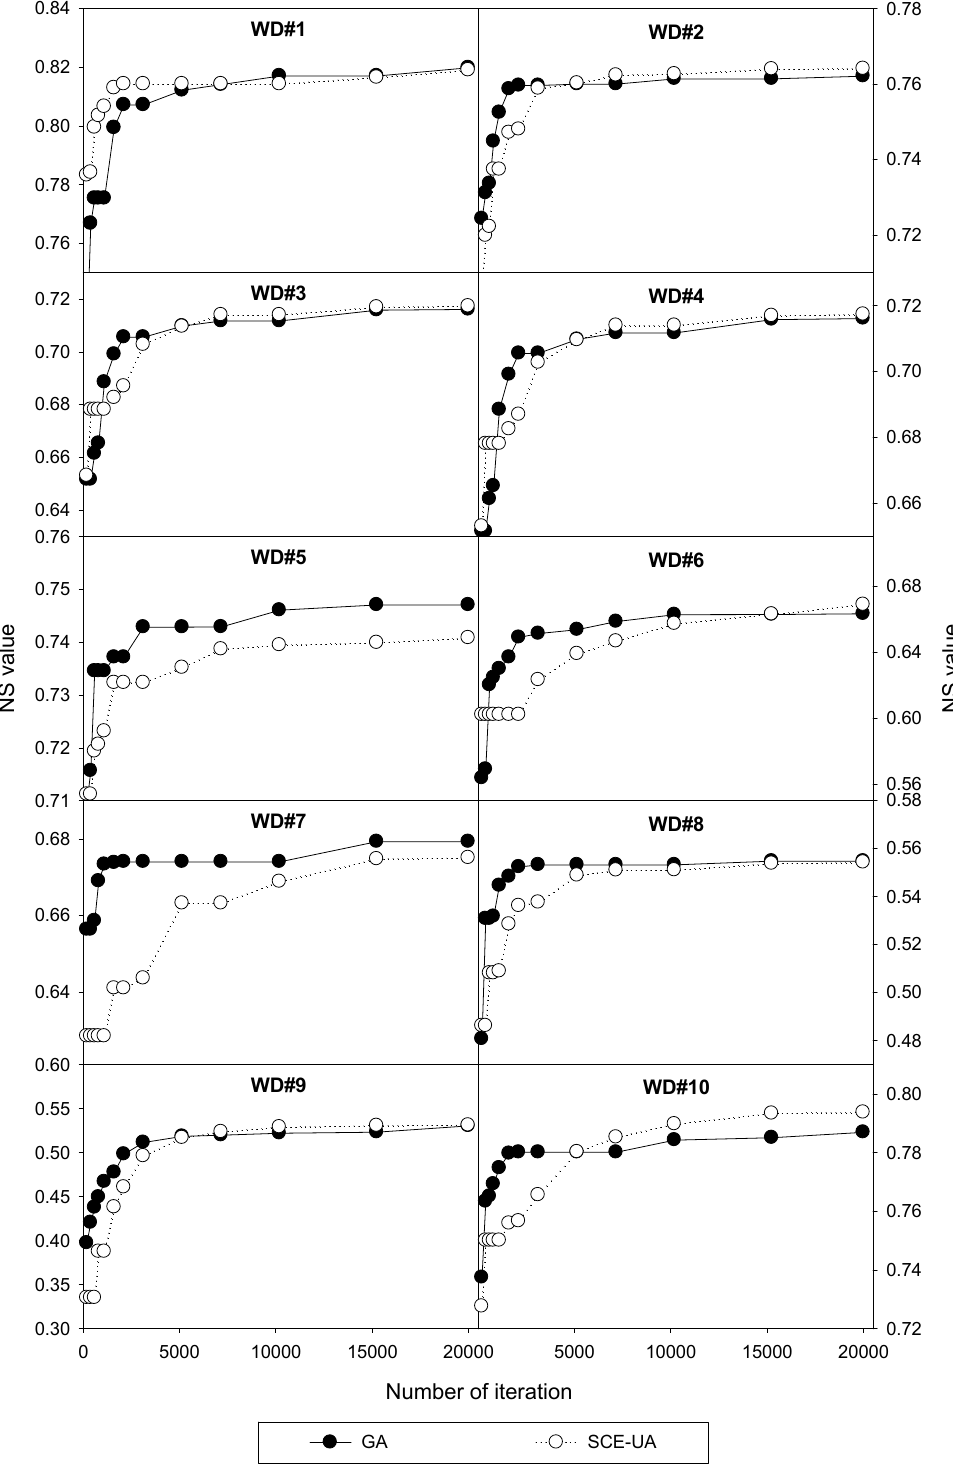
Figure 11. The performance of GA and SCE-UA for model calibration according to the total number of model